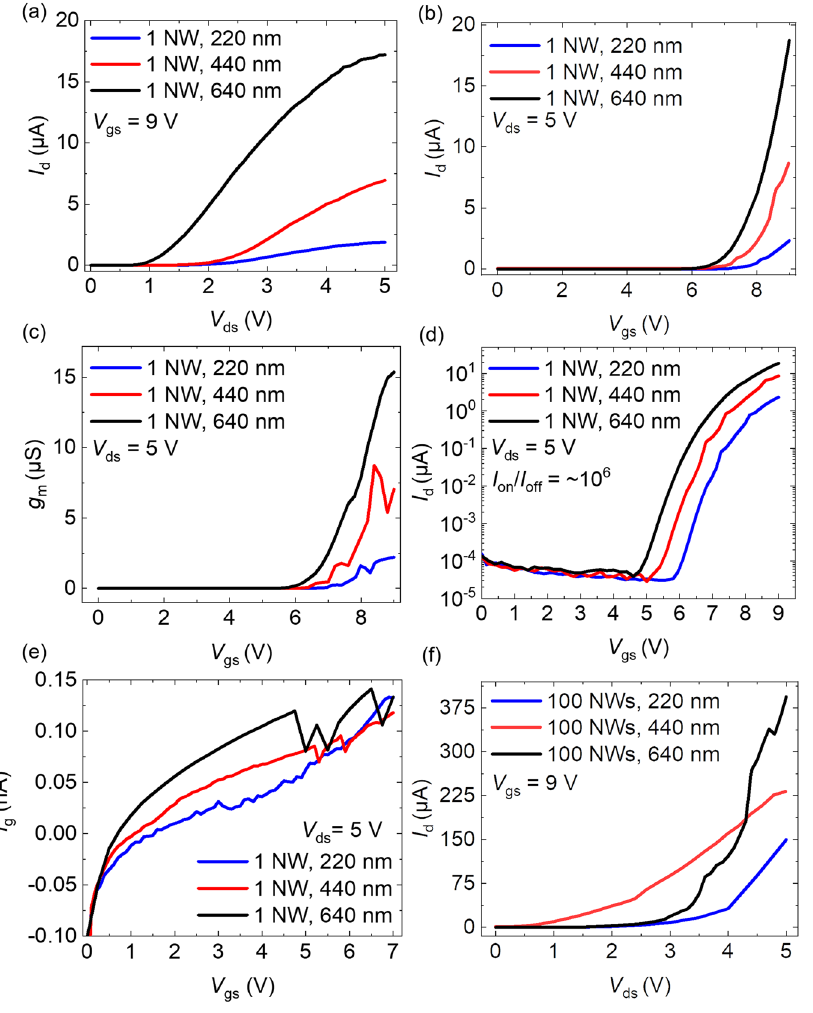
Figure 5. ( a ) Output characteristic, ( b ) transfer characteristic, ( c ) transconductance characteristic, ( d ) I on / I off characteristic, ( e ) gate leakage characteristic of 1 NW FETs, and ( f ) output characteristic of 100 NW FETs with three different diameters (i.e., 220 nm, 440 nm, and 640 nm).